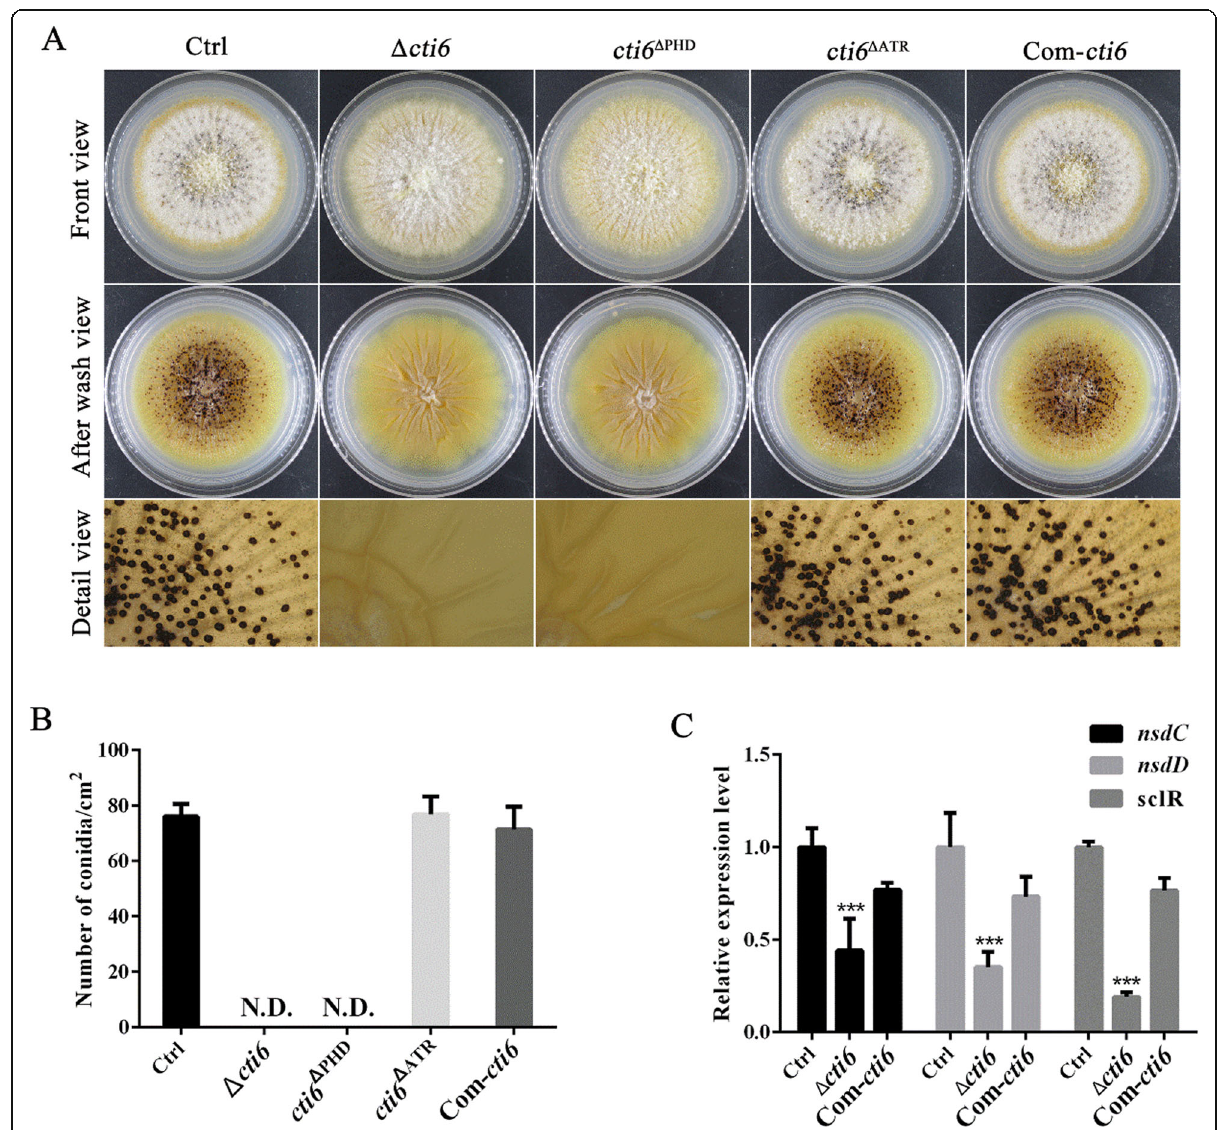
Fig. 3 Cti6 is necessary in the formation of sclerotia in A. flavus . a The A. flavus strains were point-inoculated on CM media for 7 d at 37 °C. b The sclerotia number was counted, and the sclerotia formation ability of these fungal strains was compared. c The expression levels of transcriptional factor genes ( nsdC, nsdD and sclR ) were analyzed by